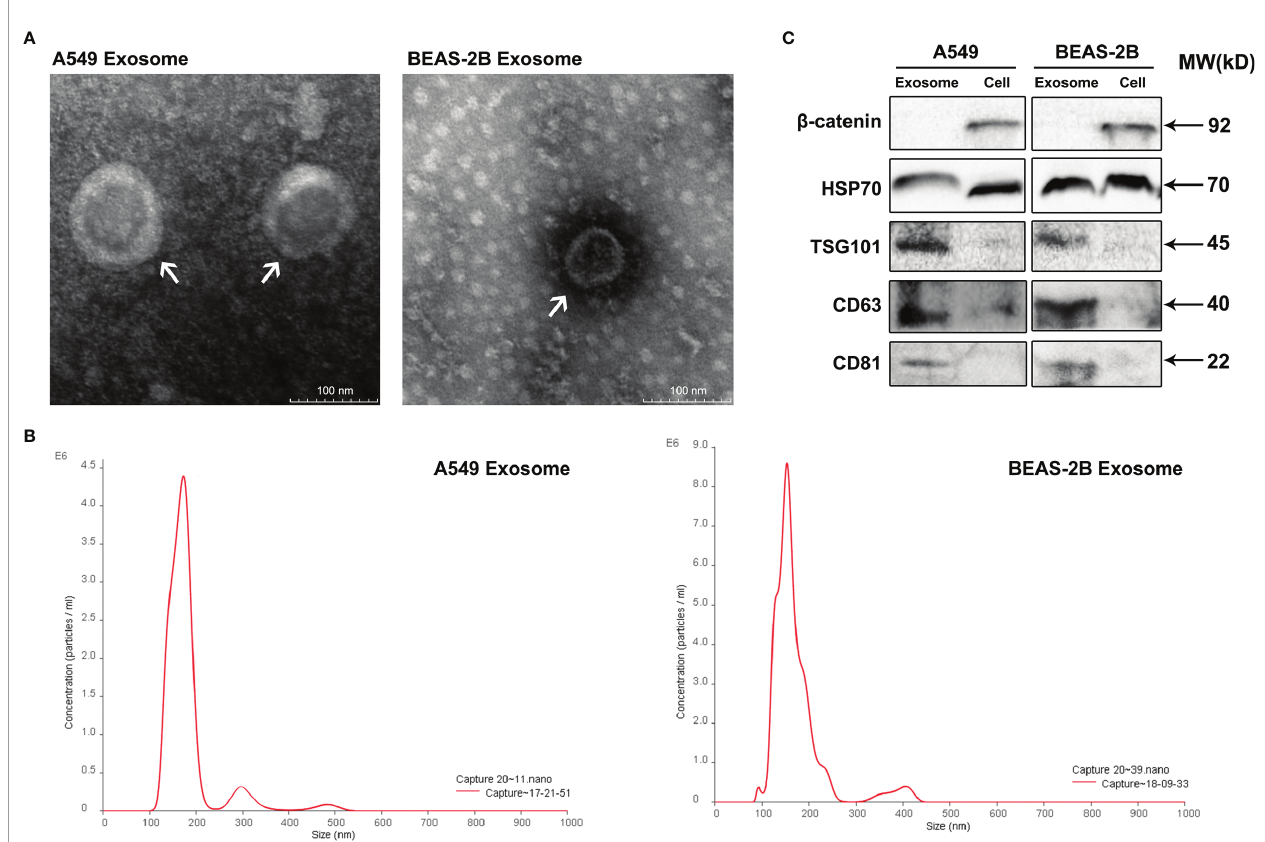
FIGURE 1 | Identi fi cation of isolated exosomes from A549 cells and BEAS-2B cells . (A) Transmission electron microscopy shows that the isolated exosomes from A549 cells and BEAS-2B cells are vesicle-like; the presented scale is equal to 100 nm. (B) The isolated exosomes were measured by NanoSight Technology for size distribution. (C) Western blot was applied to verify the expression of related proteins b -catenin, HSP70, TSG101, CD63, and